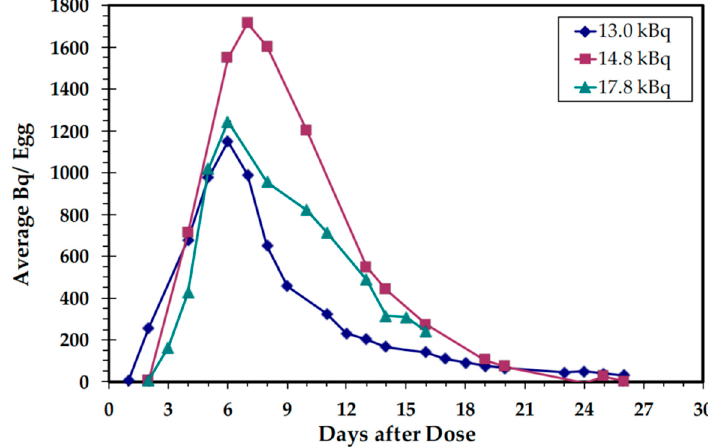
Figure A4. Time course of average 14 C activity per egg. The series indicate 14 C B12 doses delivered to different hens.